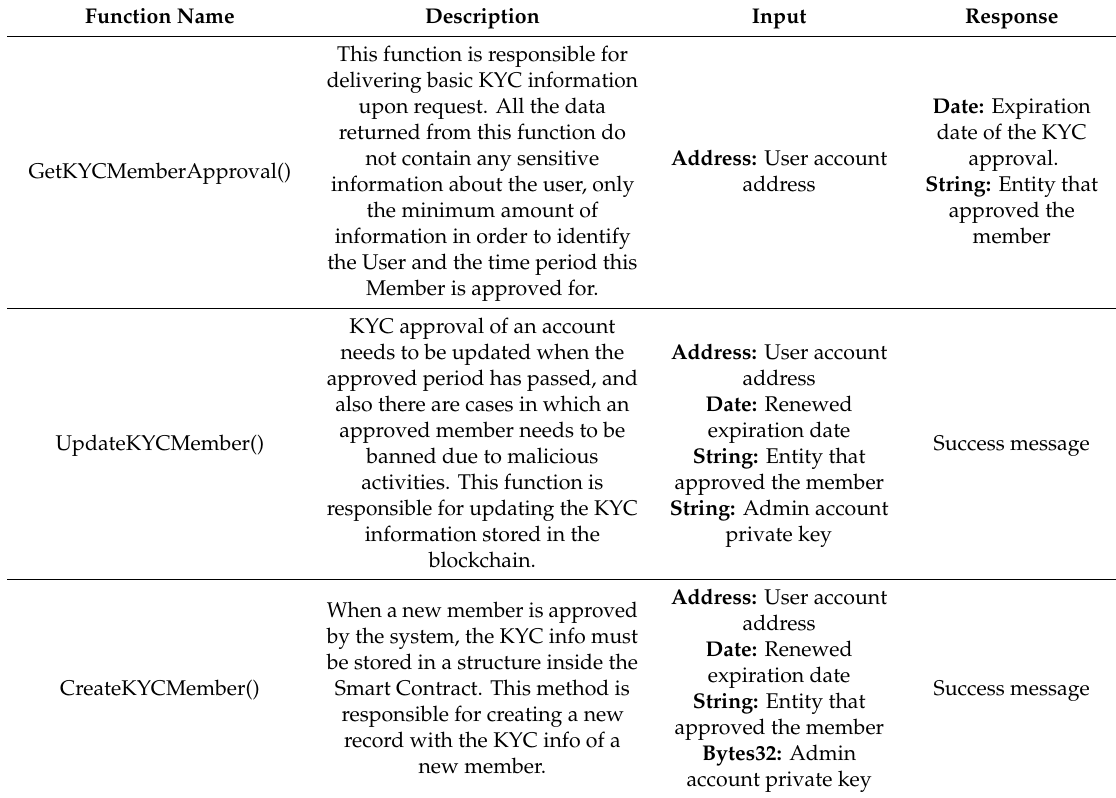
Table 1. Public smart contract methods description.